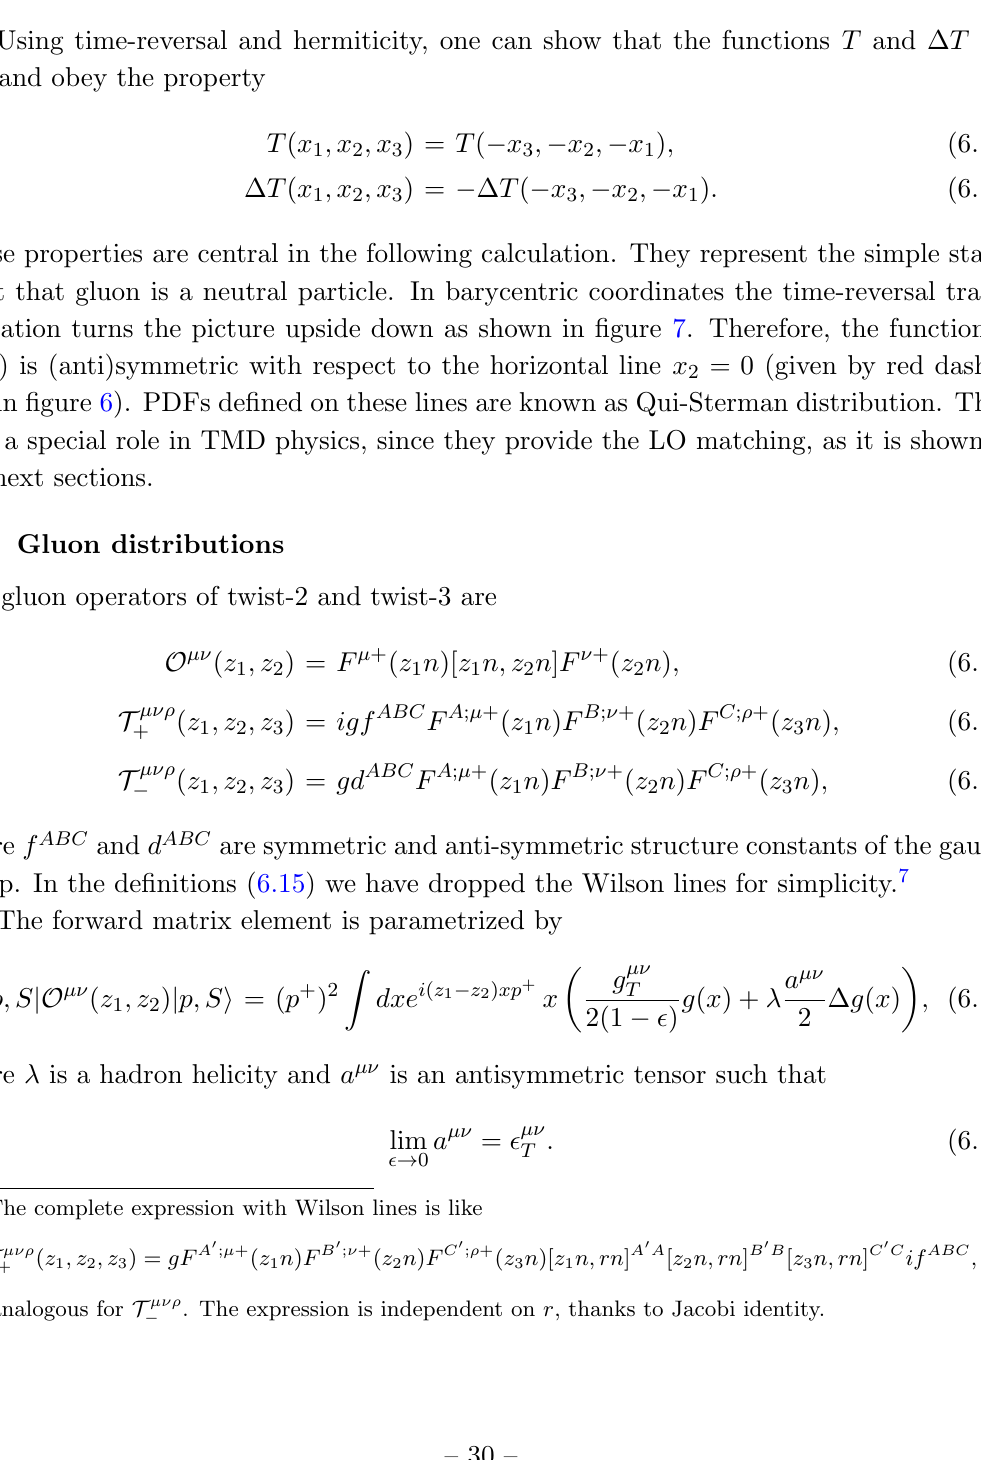
Figure 7 . The illustration for the transformation of the barycentric coordinates. From left to right: original, time-inversion, permutation of variables, cyclic permutation of